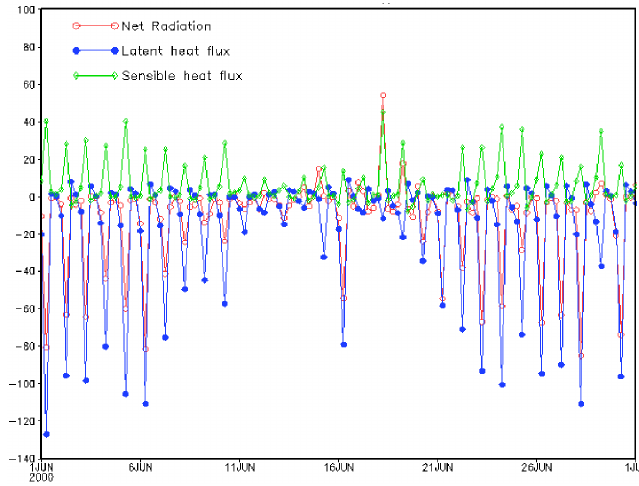
Figure 5. Simulated differences in net radiation, latent heat flux and sensible heat flux (all in W/m 2 ) at 6-h intervals for June 2000 (UTC) between Case D and Case